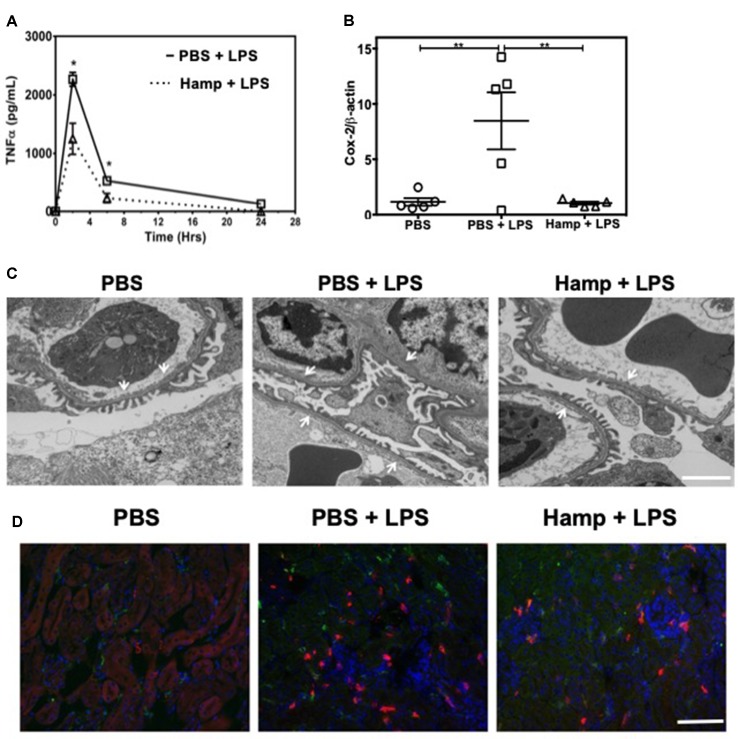
Hamp reduces LPS-induce systemic TNFα, and mediators of inflammation like Cox-2 and protects the renal ultra-structure and reduces immune cell infiltration. Mice were treated with PBS or Hamp (50 µg/mouse, I.P.) 24 hr before injecting them with 6.5 mg/kg LPS. Hamp pretreatment significantly reduced LPS-induced serum TNFα levels at 2 and 6 hours (A). Similarly renal Cox-2 gene expression was also reduced by hepcidin pretreatment (B). *P < 0.05, **P < 0.01. Data points are plotted as mean ± SEM (n = 4-5 per group). Representative electron micrographs of glomeruli from three groups of mice are shown. PBS treated mice show a glomerular capillary with normal fenestrated endothelium and podocyte foot processes which are fused following LPS treatment. (C). This loss/fusion of the endothelial fenestrae is reduced by Hamp pretreatment. (C). Original Magnification: 8,000X, Scale bar = 2 µm. Following LPS treament, there were a large number of neutrophils (7/4 antigen; magenta), CD11b+ve cells (CD11b; red) and macrophages (F4/80: green) in PBS-treated mice that were reduced by Hamp treatment (D). Scale bar = 100 µm. Experiments with 4-5 mice each were repeated twice and representative data from a singe experiment is depicted.